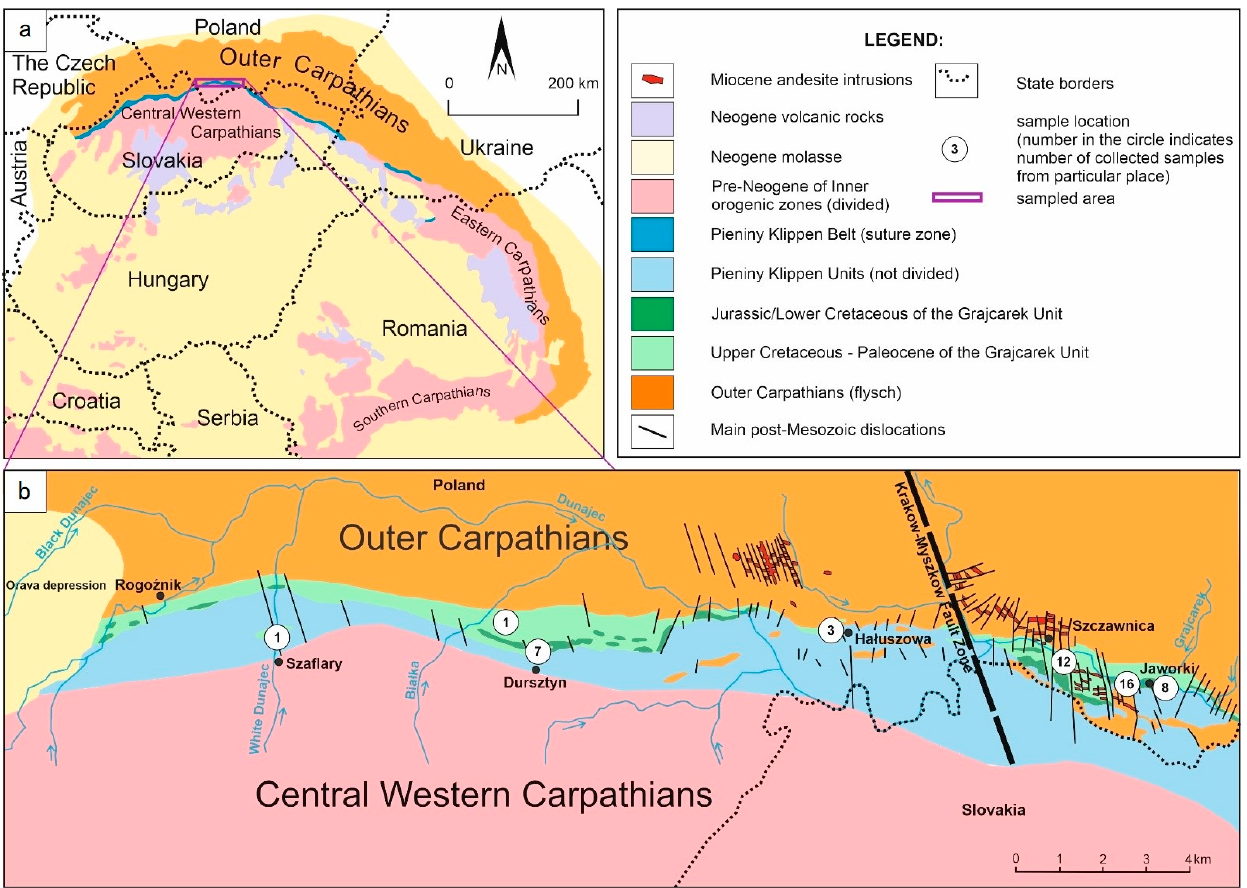
Figure 1. ( a ) Geological map of the Carpathians and adjacent areas with the location of investigated area (modified from [52–54]); ( b ) enlarged sample area marked in ( a ) showing the simplified geological structure of the Pieniny Klippen Belt of Poland (modified from [55]).